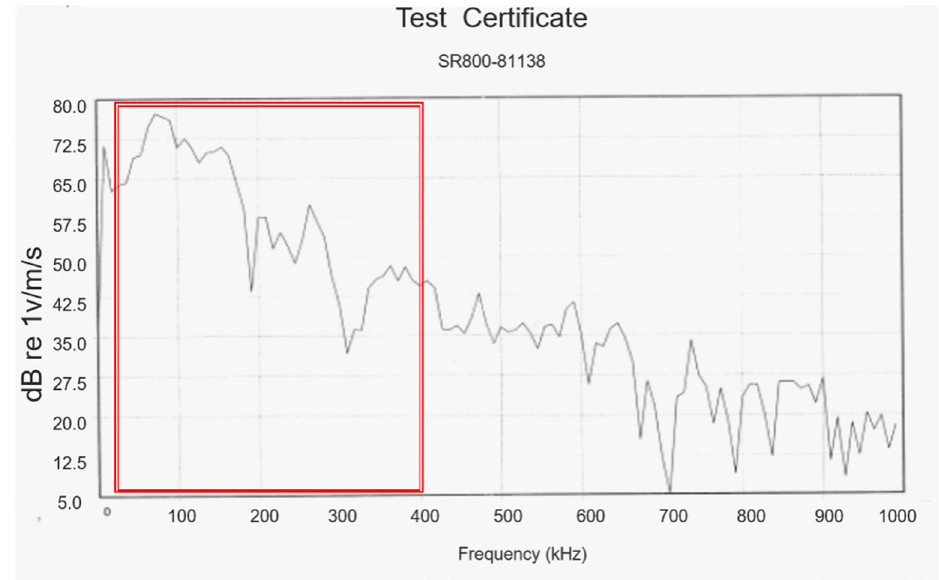
Figure 2. The frequency characteristic curve of the acoustic emission sensor SR800.